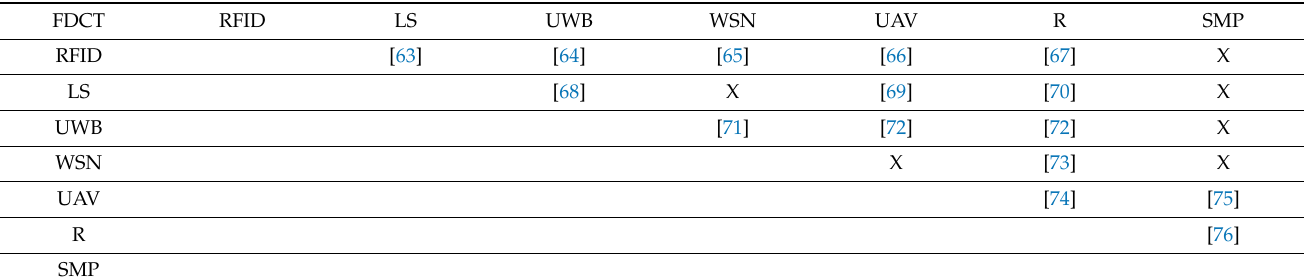
Table 8. Interoperability matrix among field data capture technologies—intra-FDCT.